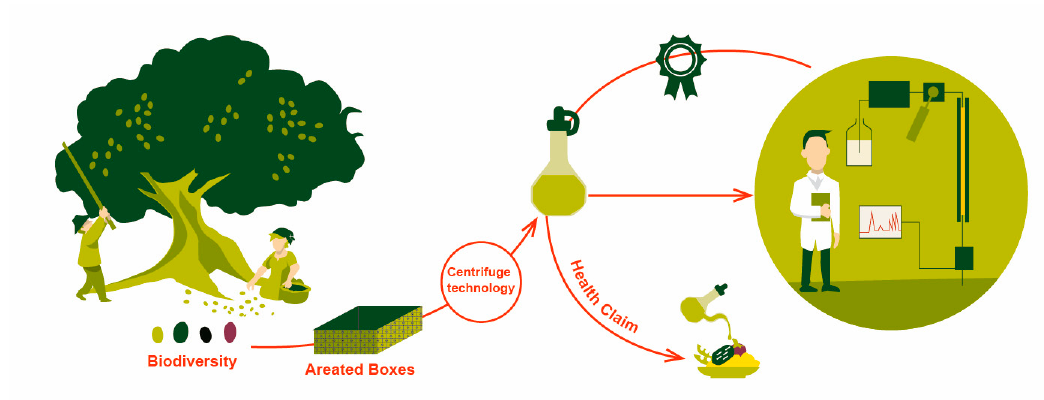
Figure 4. Graphical abstract of the steps for the oil quality management concluding with the connection to territorial labs for certification by an official analytical method.